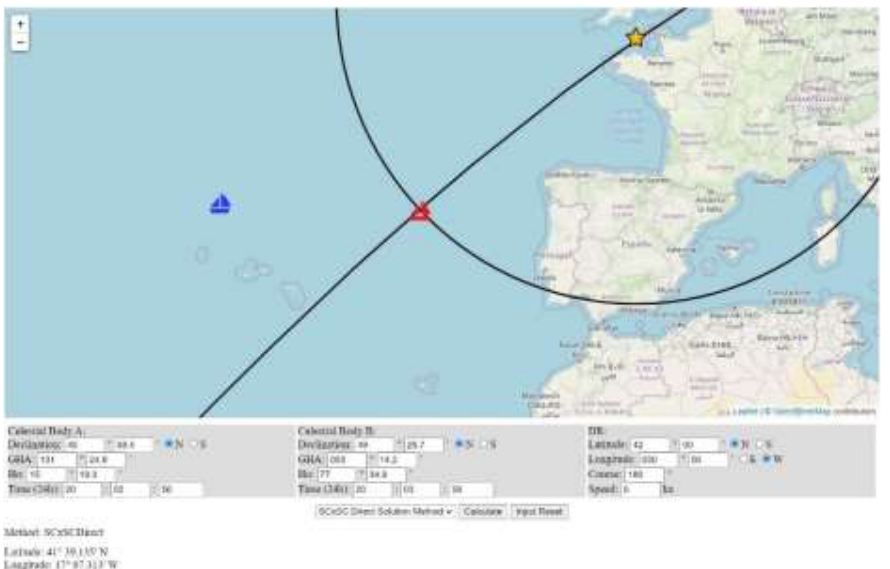
Figure 8. The GUI of the closed analytical solution method calculation program (for Example 1).